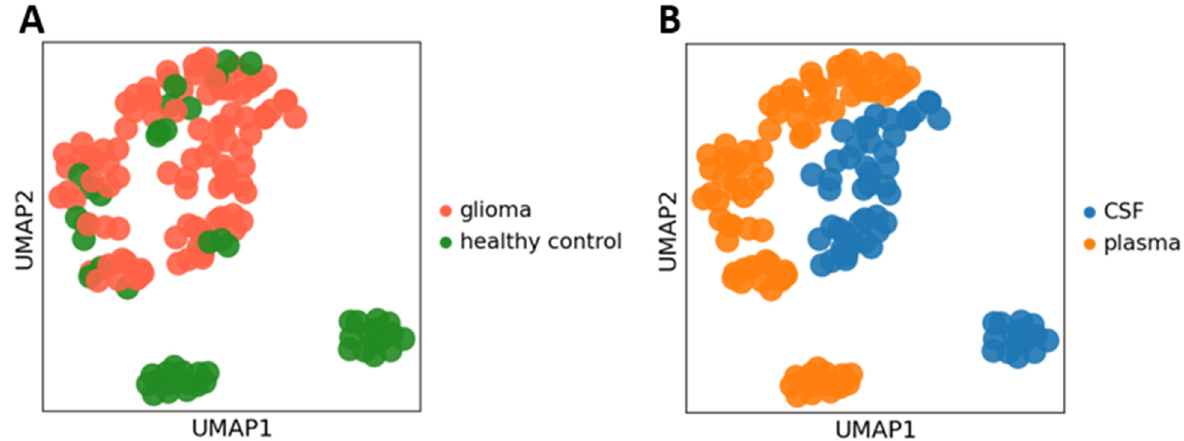
Figure 1. The projection of metabolic profiles onto a 2D space using the Uniform Manifold Approximation and Projection (UMAP). Each point corresponds to a single metabolic profile measurement. ( A ) Points are colored in red and green for glioma patients and control group, correspondingly. ( B ) Points are colored in blue and orange for CSF and plasma samples, correspondingly. PCA and UMAP coordinates were calculated for the log-transformed measurement values using SCANPY python package [22].